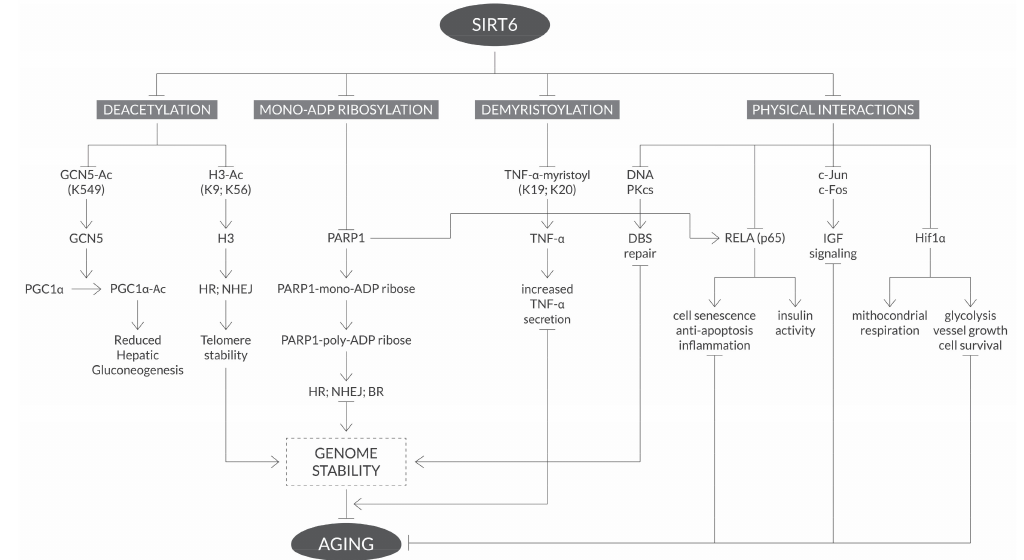
Figure 1. SIRT 6 activities and functions. SIRT6 described activities, substrates and responses related to the aging